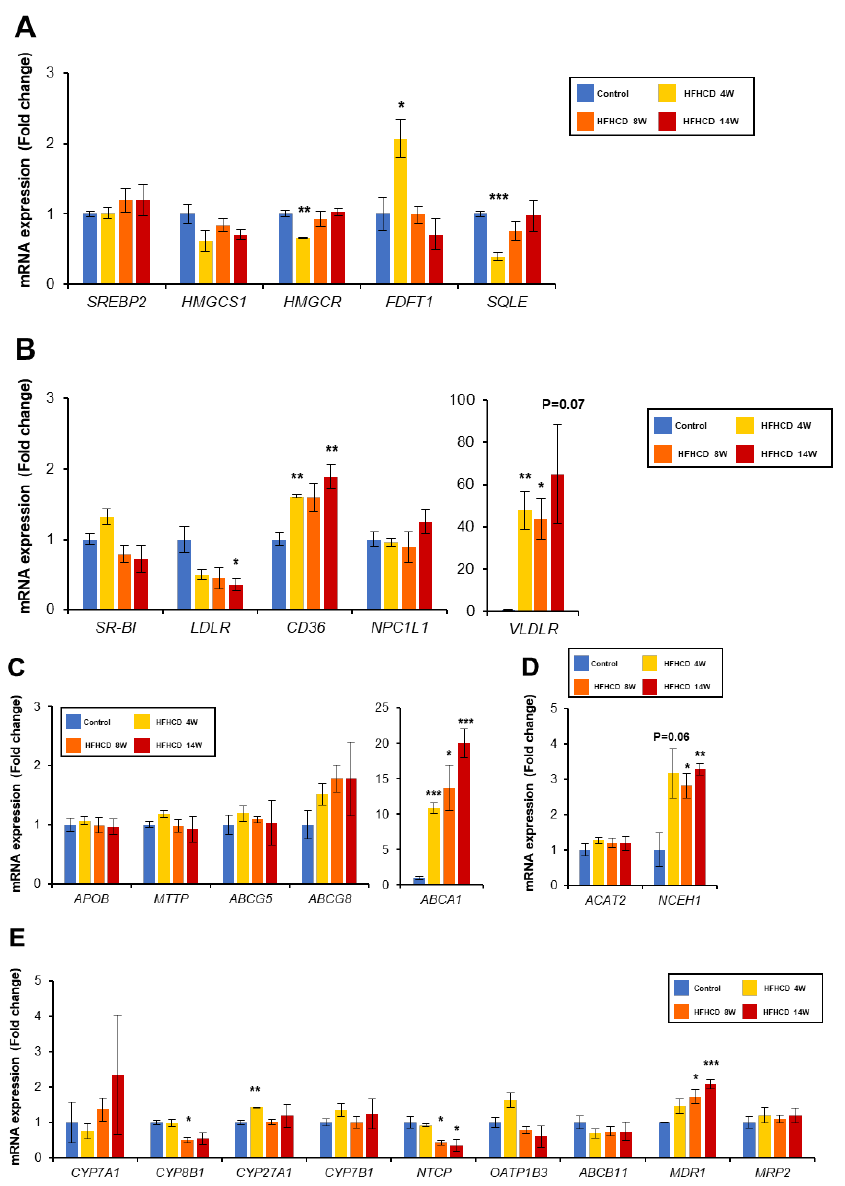
Figure 3. HFHCD altered the gene expression of cholesterol metabolism. Hepatic mRNA levels of genes related to cholesterol synthesis ( A ), cholesterol uptake to the liver ( B ), cholesterol excretion ( C ), cholesterol esterification and hydroxylation ( D ), and bile acid metabolism ( E ) were quantified using real-time PCR and normalized to GAPDH. Data are shown as the mean ± SEM. * p < 0.05, ** p < 0.01, and *** p < 0.001 vs. control group. Control group (12 weeks, n = 3), HFHCD group; 4 weeks (n = 3), 8 weeks (n = 4), 14 weeks (n = 4).